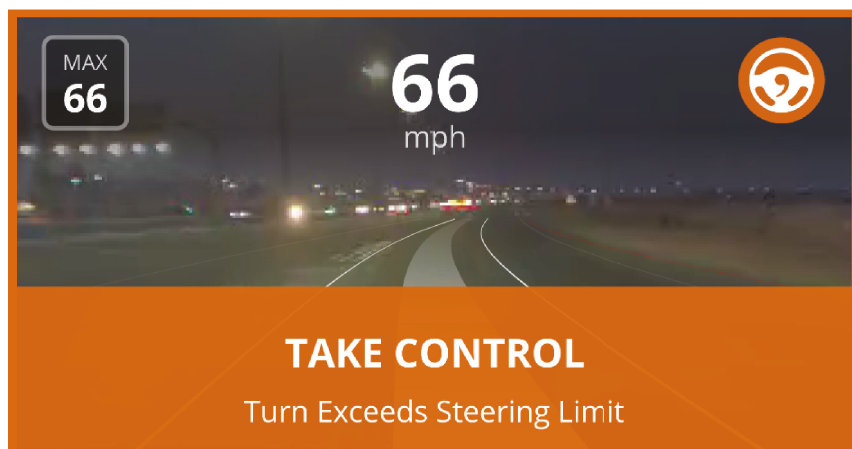
Figure 40: OP steering limitation warning.